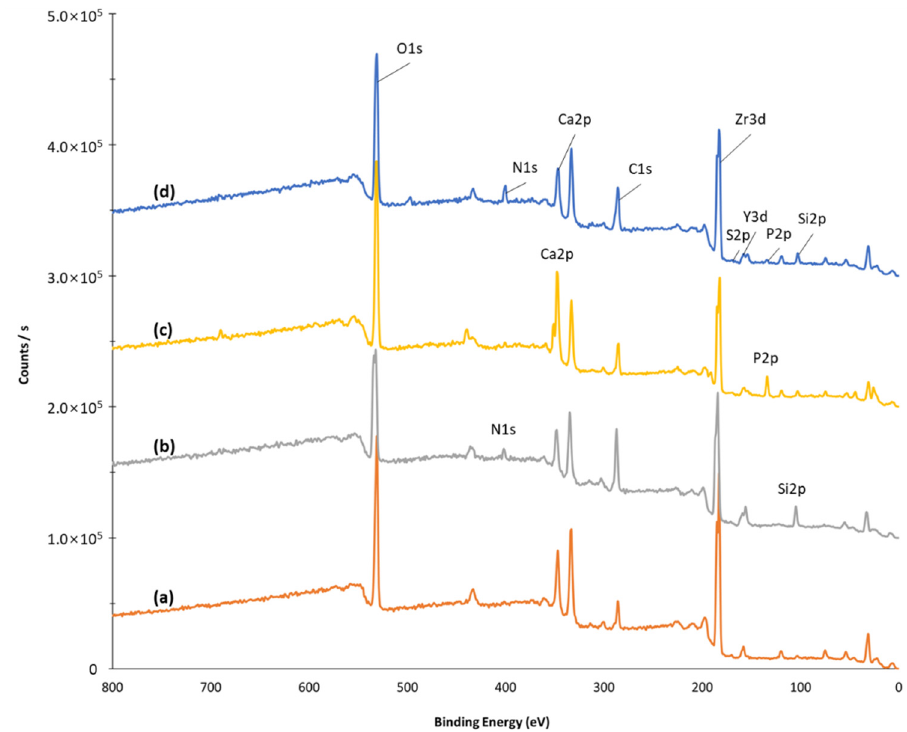
Figure 6. X-ray photoelectron spectroscopy of ZrO 2 ( a ), ZrO 2 -NH 2 ( b ), ZrO 2 -HA ( c ), and ZrO 2 -HA- Col ( d ). After the APTES reaction, the Si peak appeared at 100 eV, after the HA reaction, the peaks due to P and Ca at 120 and 320 eV, and after the collagen reaction, the peak due to nitrogen appeared at 400 eV.